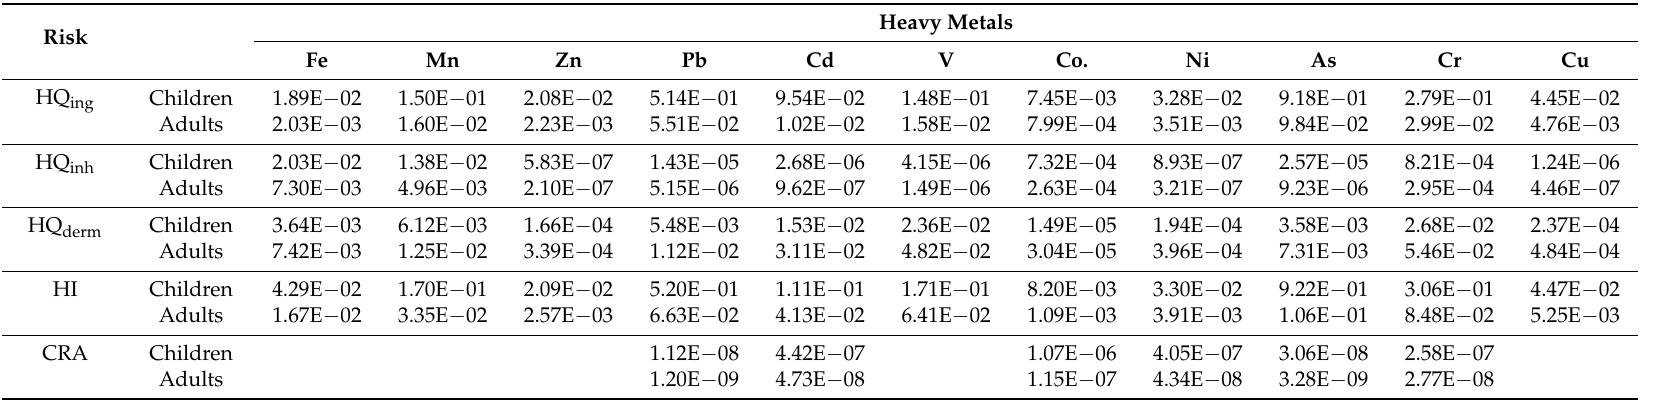
Table 8. Hazard quotient, hazard index and carcinogenic risk of average concentrations of each heavy metals for both children and adults population living in urban areas of